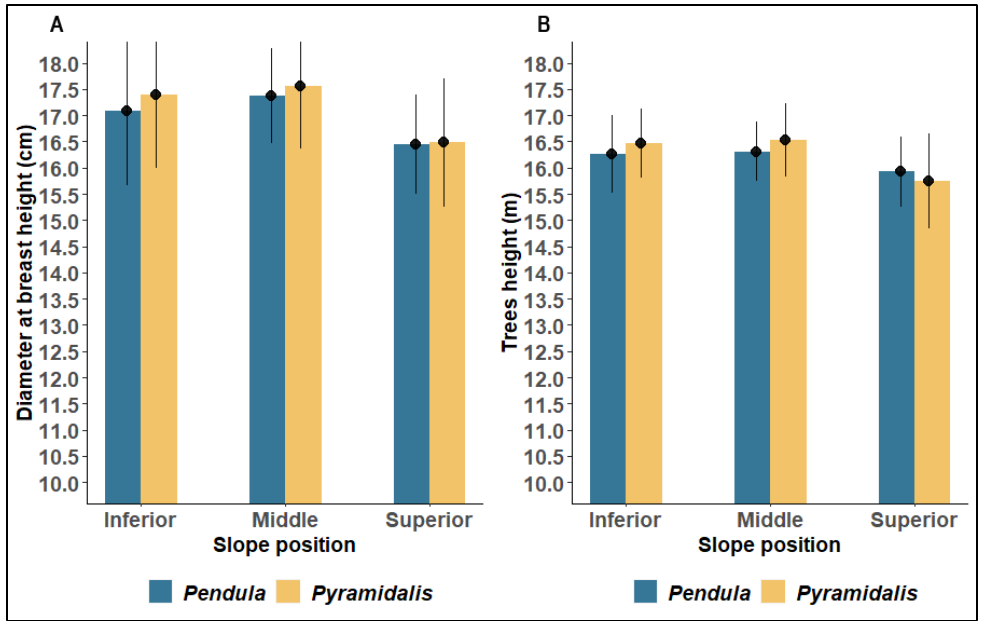
Figure 10. Variation in the growth traits: diameter at breast height ( A ) and tree height ( B ) by the slope position. The black vertical lines represent the standard deviation.